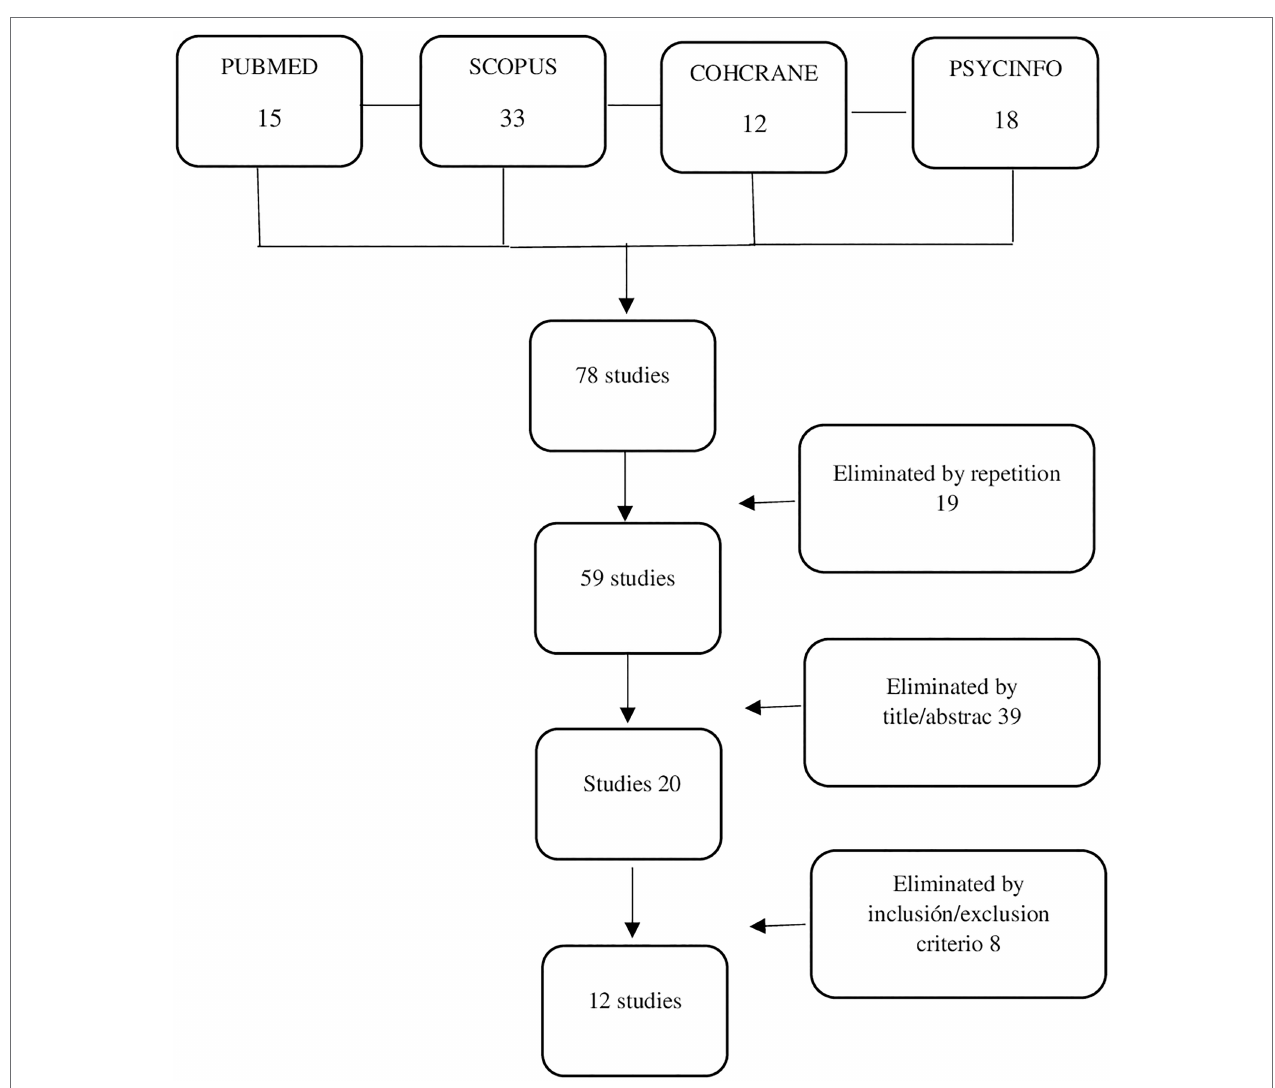
FIGURE 1 | Prisma flow diagram for the selection of the literature included in this